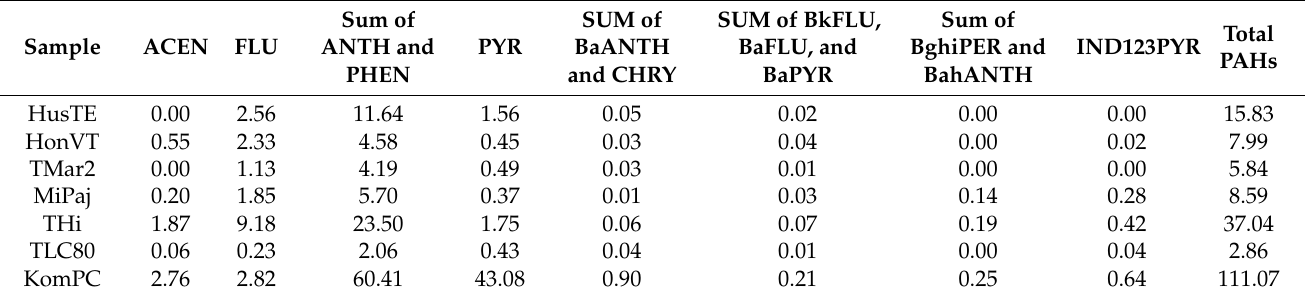
Table 3. PAH content in the stock suspensions of VEPs, µ